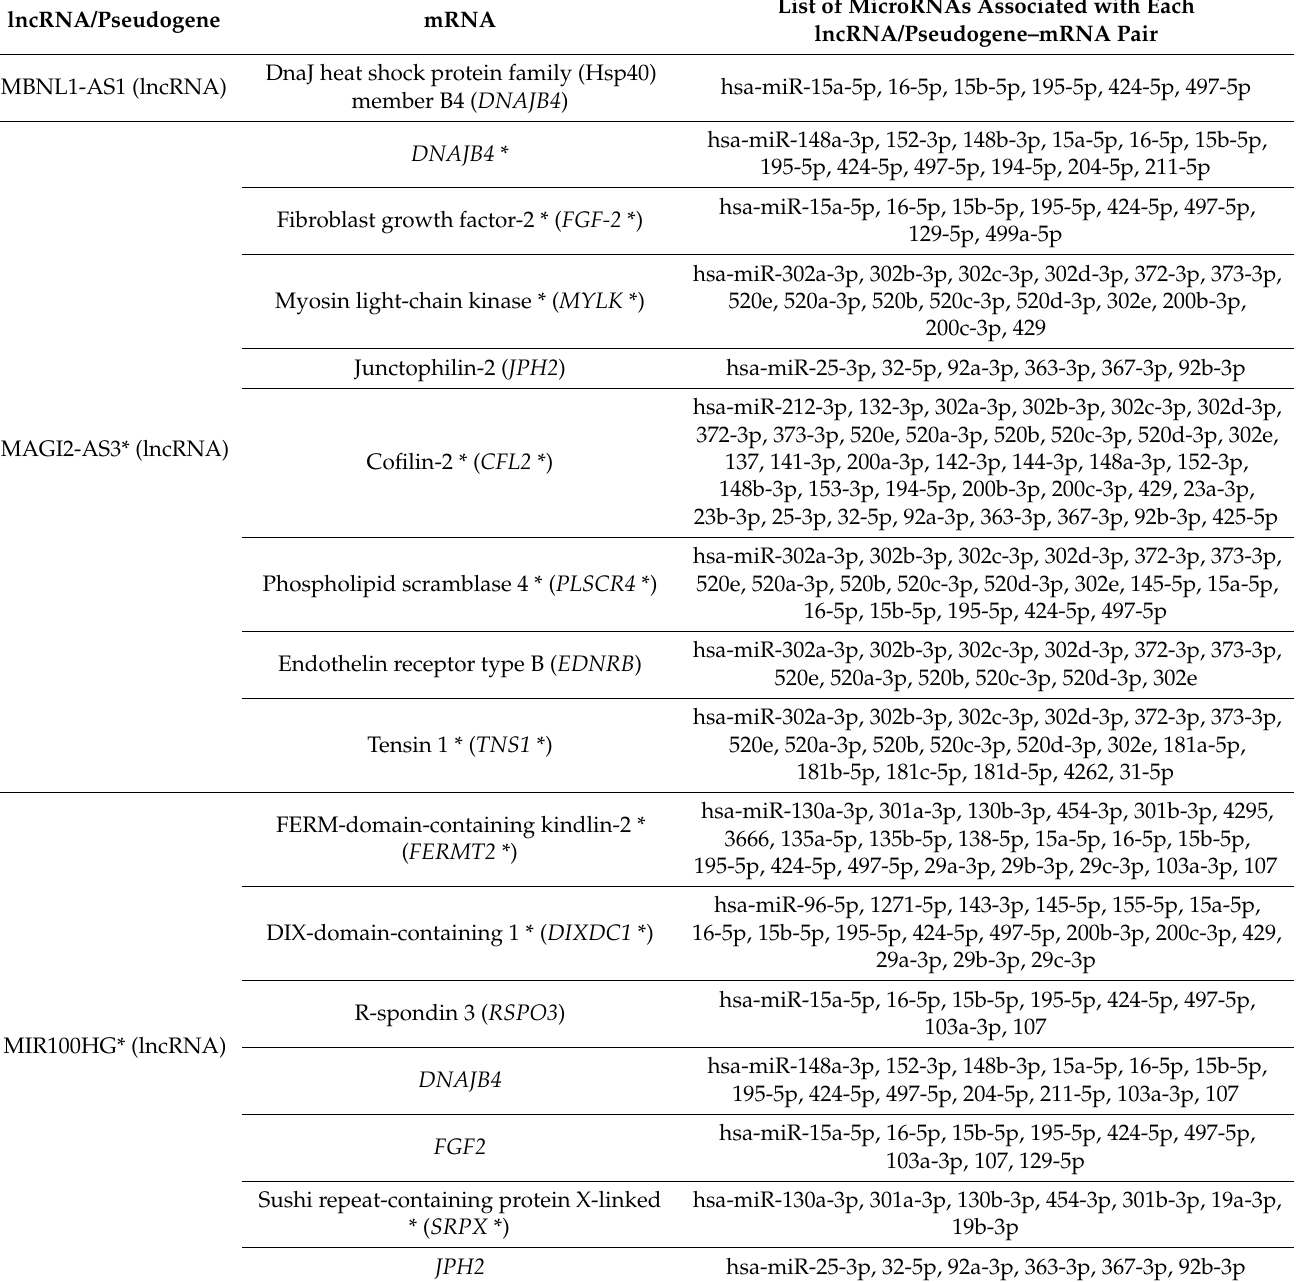
Table 2. Shared lncRNA and pseudogene-associated ceRNA associations among hormone-dependent (HD) cancers. lncRNA/Pseudogene mRNA